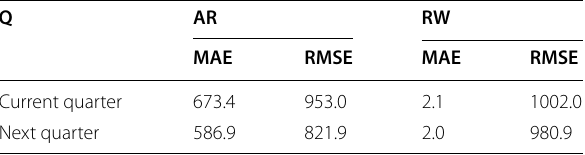
Table 13 MAE and RMSE loss functions for changes in inventories